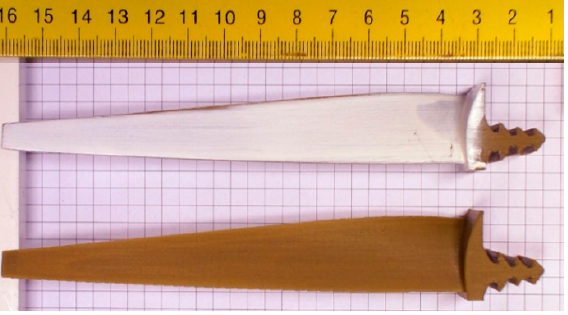
Figure 6. A blade before (bottom) and after (top) surface treatment by filling, fine grinding and lacquering; scale in centimeters.